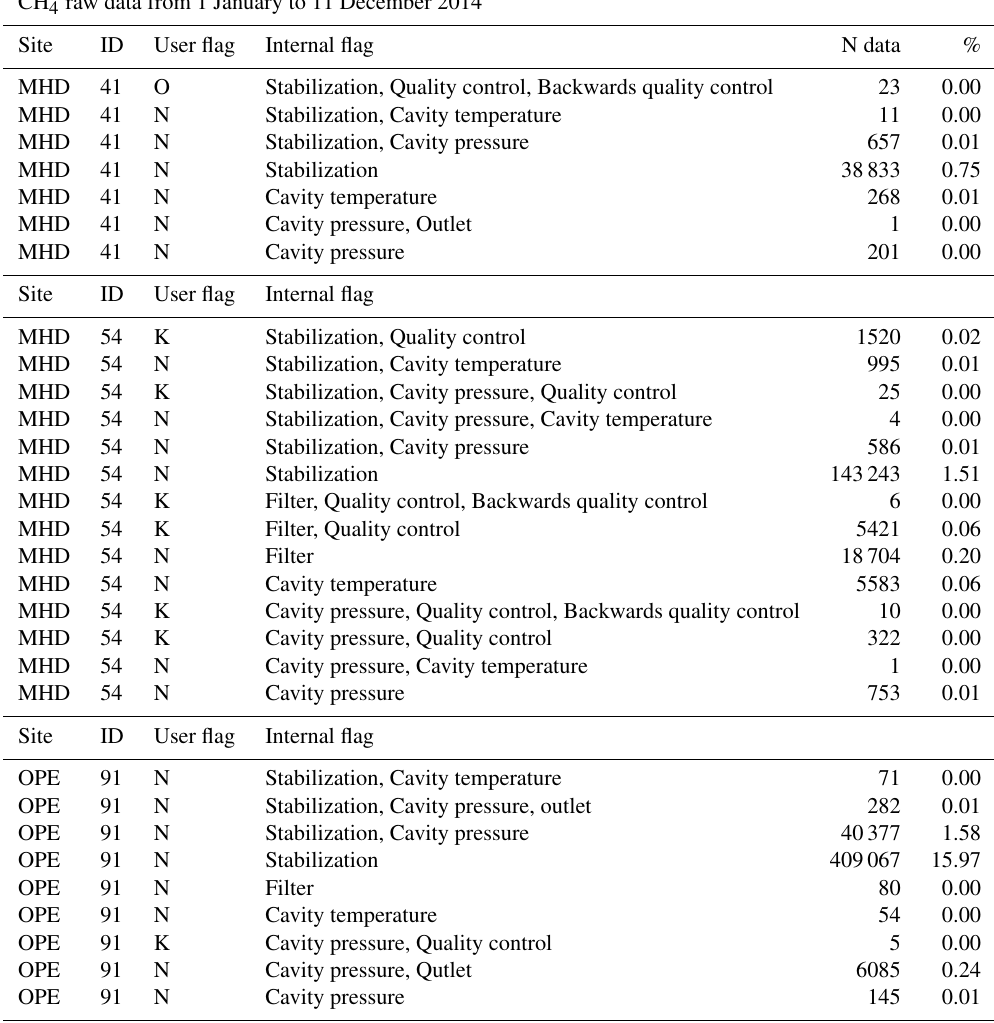
Table 6. Examples of user and internal flags that were attributed to raw data from CRDS Picarro instruments in 2014. The two last columns provide the number of raw data that have been attributed an internal flag or combination of internal flags and the corresponding percentage in the dataset. Most of the data have no internal flag, indicating that there is no anomaly